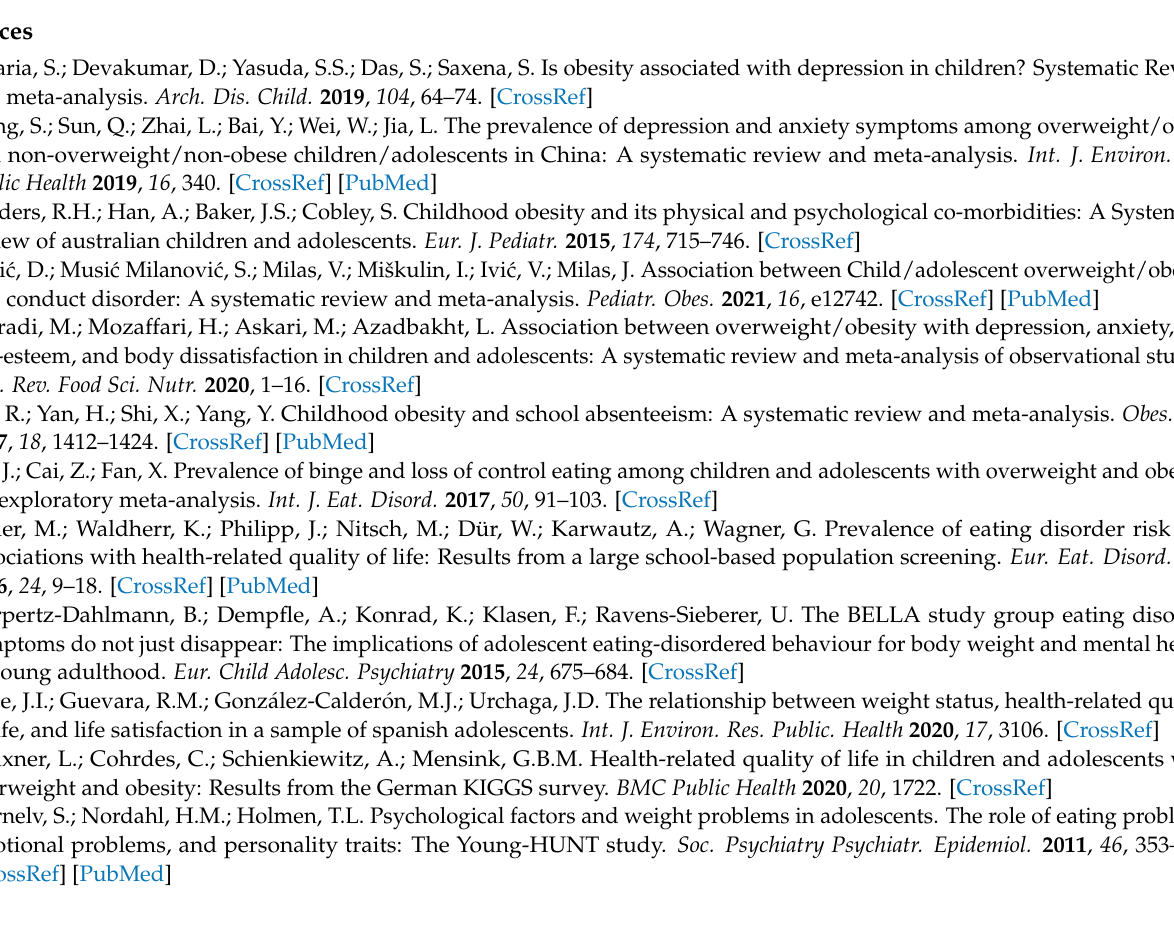
Figure S2: Correlation stability plot measuring the stability of betweenness, closeness and strength indices in the underweight subsample, Figure S3: Edge accuracy plot depicting 95% confidence obtained from 1.000 bootstrap samples drawn from the population overweight adolescents, Figure S4: Edge accuracy plot depicting 95% confidence obtained from 1.000 bootstrap samples drawn from the population underweight adolescents, Figure S5: Network plot and centrality indices plot for adolescents with normal